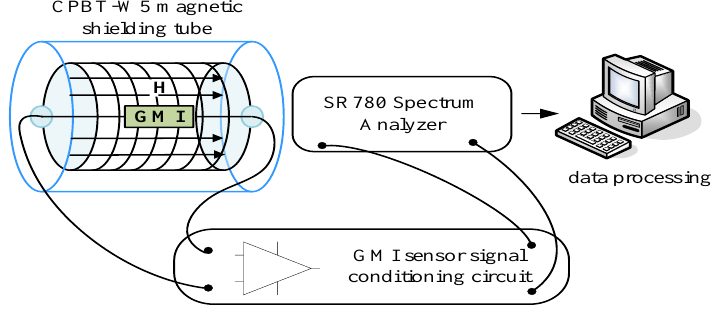
Figure 5. GMI magnetic sensor noise test system diagram.